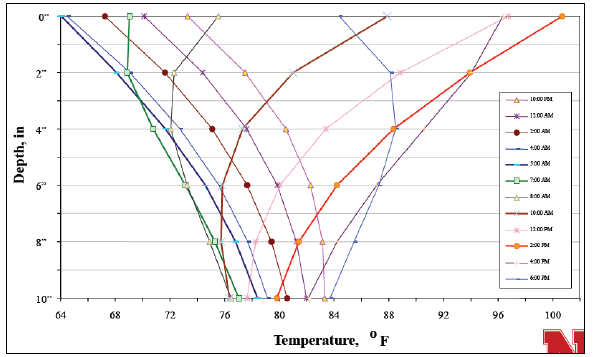
Figure 2: PCC temperature profile [49]